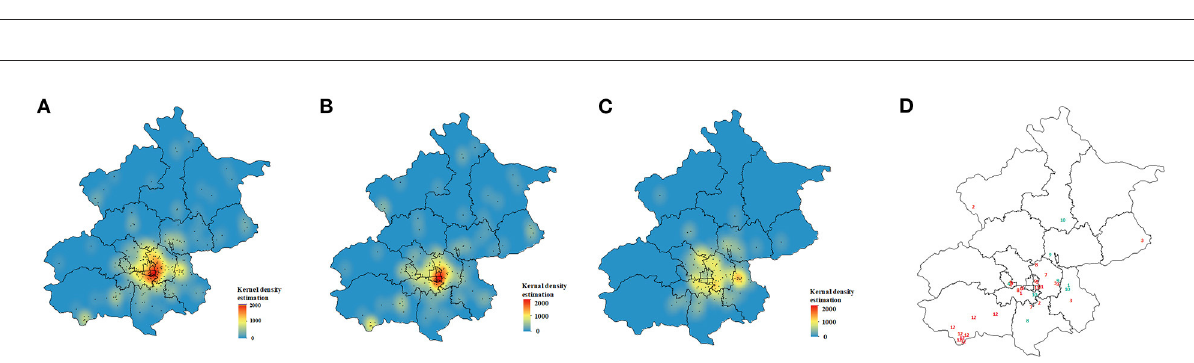
FIGURE3 Spatial distribution of multidrug-resistant tuberculosis cases. (A) Kernel density estimation for all 241 patients, (B) resident patients and (C) migrant patients. (D) Spatial distribution of genetic clusters; red numbers represent resident patients and green numbers represent migrant